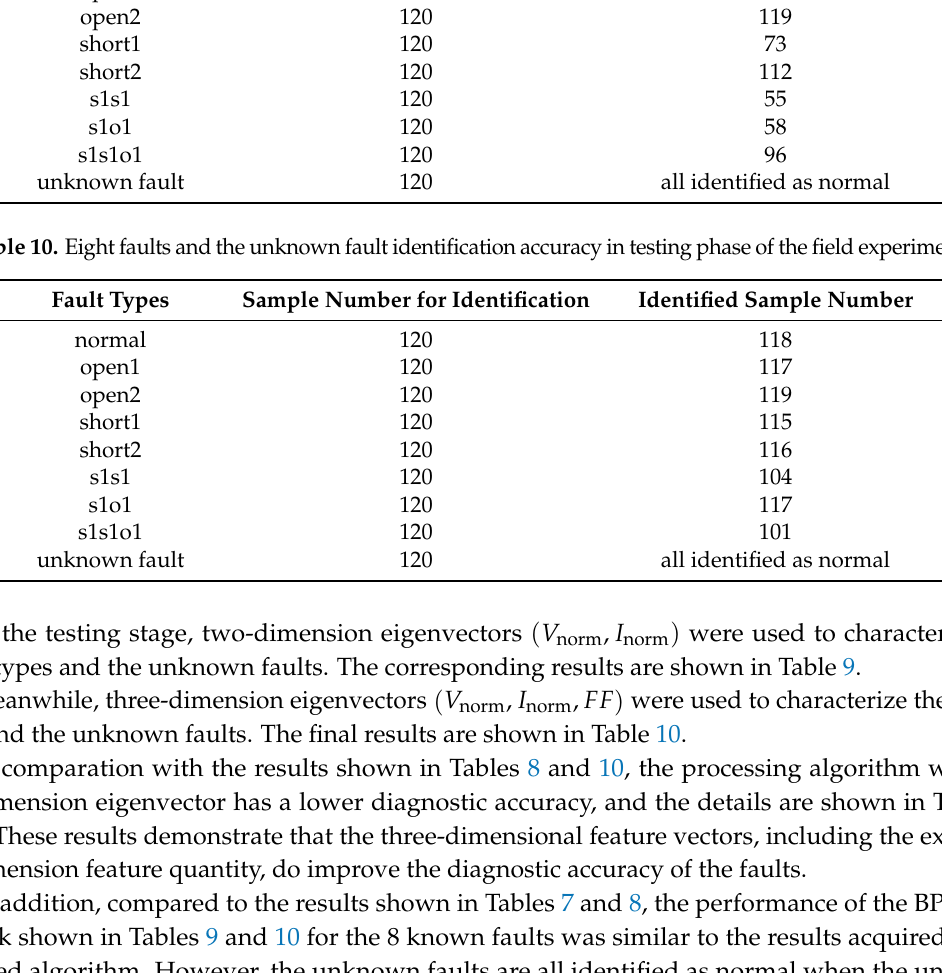
Table 9. Eight faults and unknown fault identification accuracy in testing phase of the field experiment.